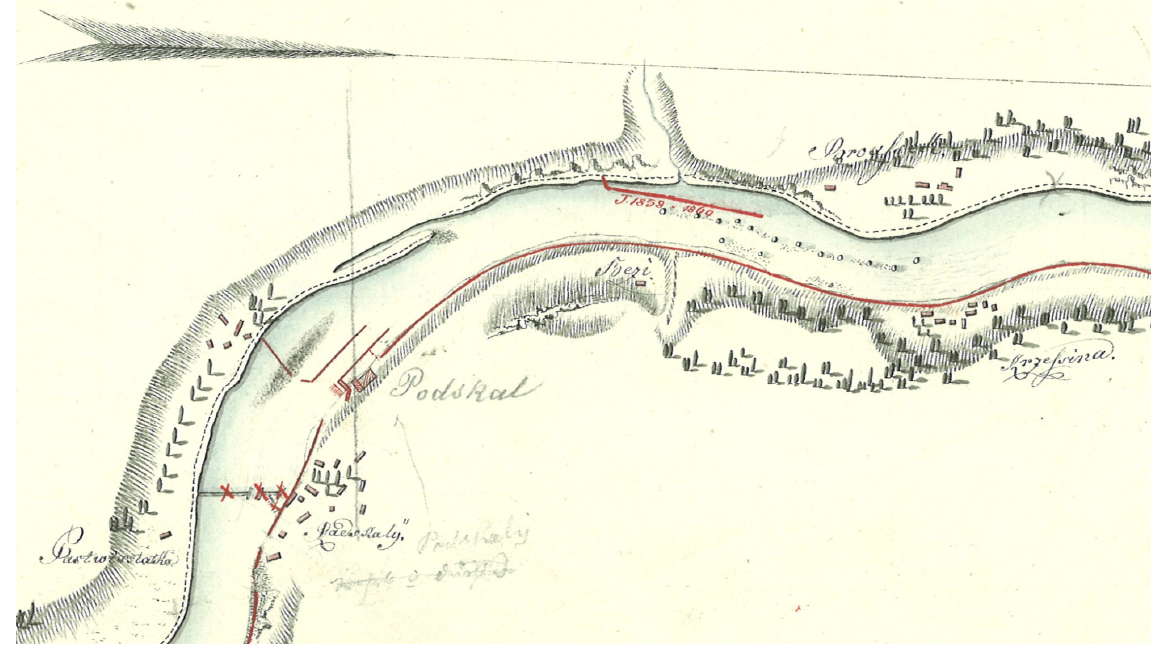
Figure 1. Depiction of a manuscript river map derived from the Ebert’s map of the Vltava river from eighteenth century, Source: Archive of the Povodí Vltavy, State Enterprise (Prague, Czech Repub- lic). Table 2. Topographic surveys of the Habsburg Monarchy in the research area, Source: author’s elaboration.